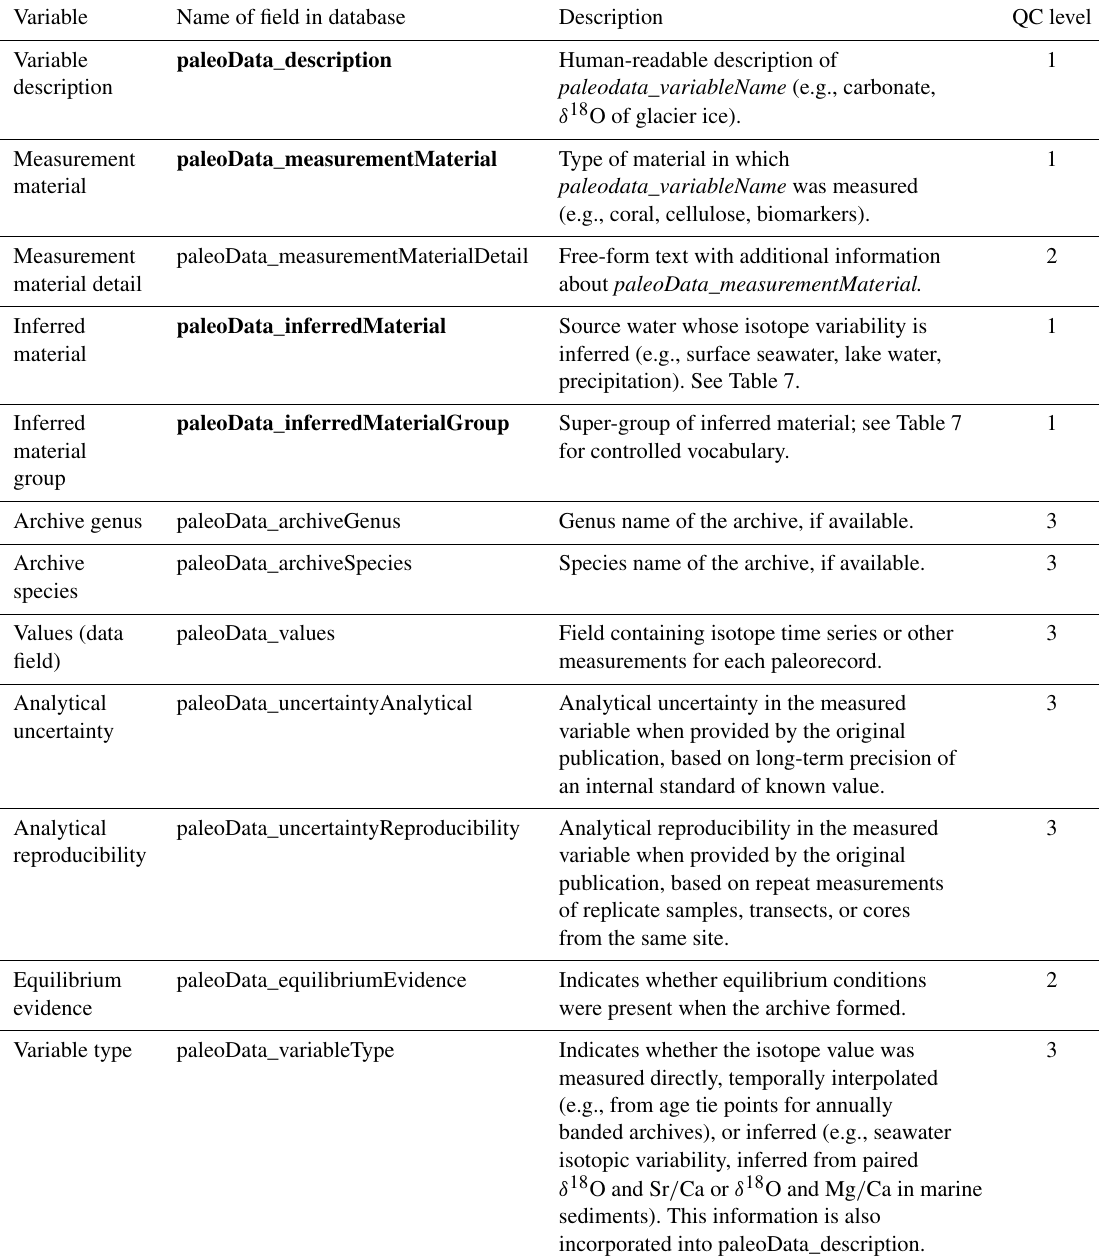
Table 2. Key paleodata metadata. Bold text indicates Level 1 or required fields in the database. italics are references to other metadata or variable; italics are references to other metadata or